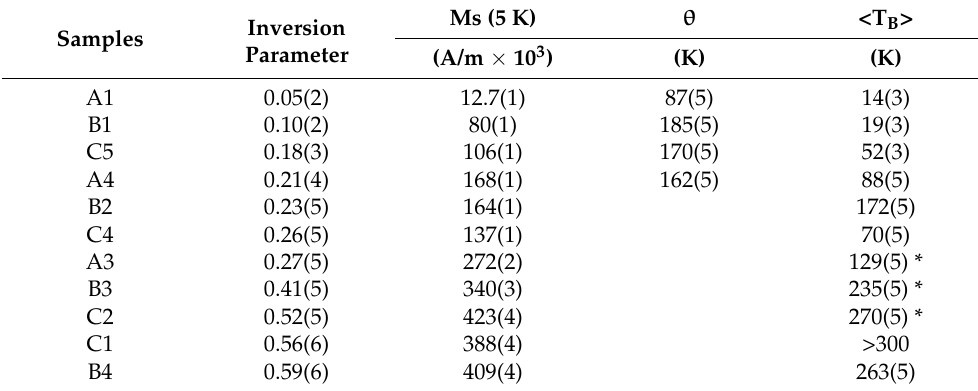
Table 2. Inversion degree, saturation magnetization, apparent Curie – Weiss (θ) , and average block- ing temperature <T B > of the studied samples.